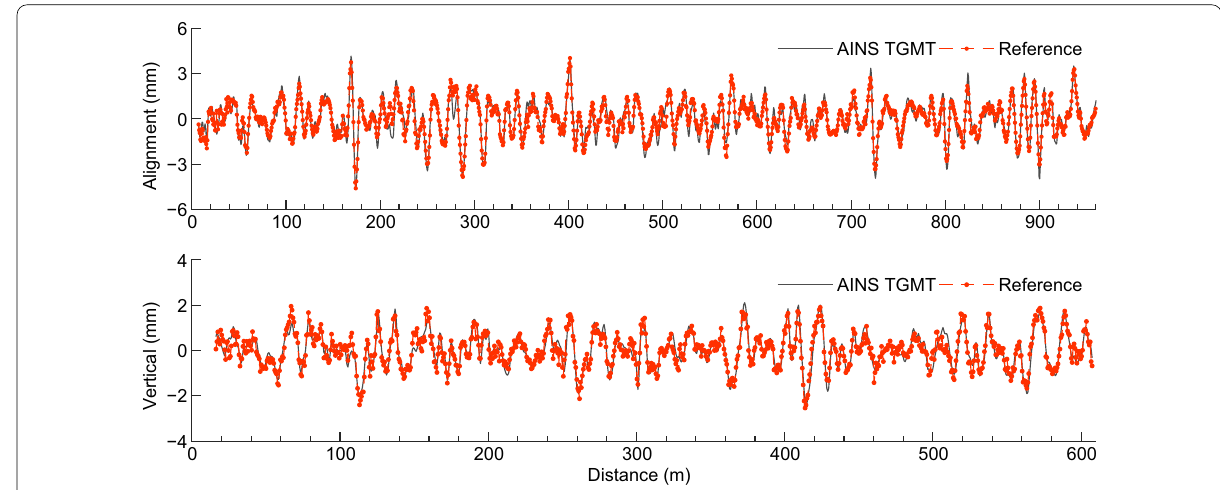
Fig. 7 Comparison of the short wavelength track irregularity measurements by a GNSS/INS trolley with the independent